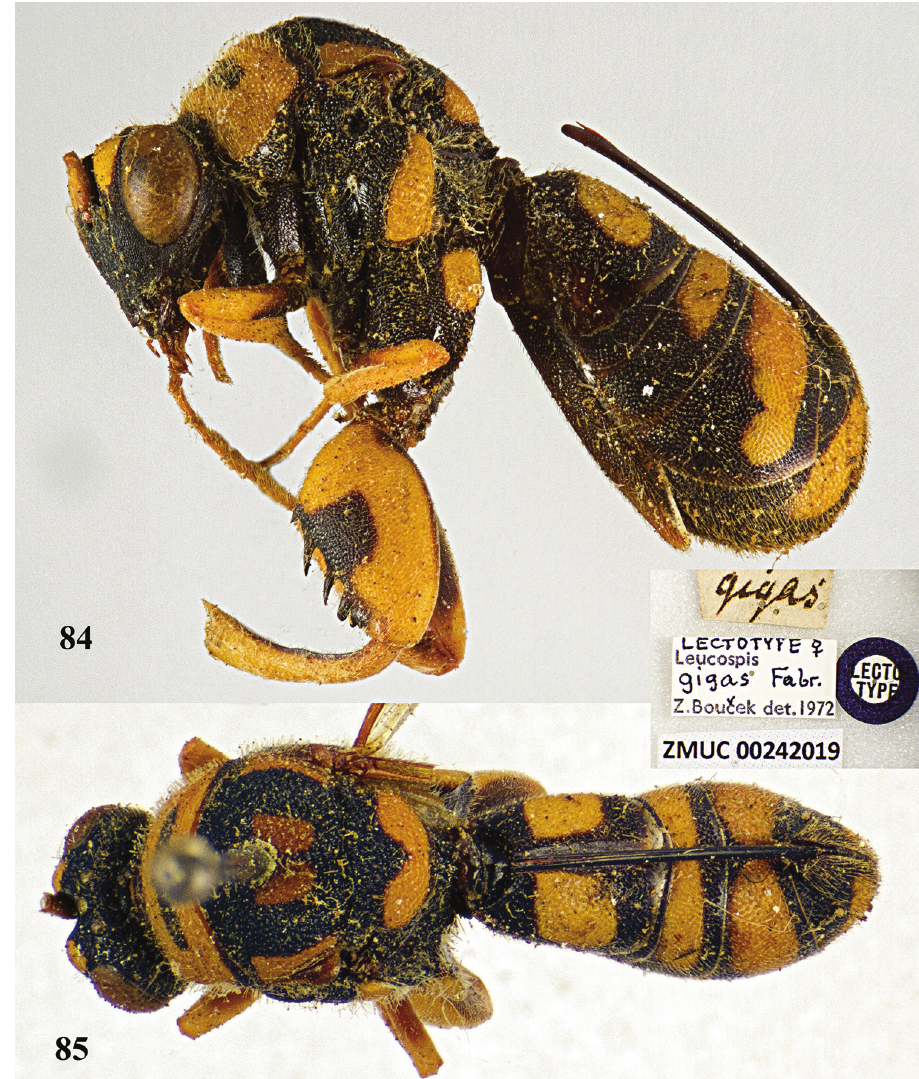
Figures 84, 85. Leucospis gigas Fabricius, ♀ , lectotype. 84 Habitus lateral 85 habitus dorsal (courtesy of Dr. Lars Vilhelmsen, Natural History Museum of